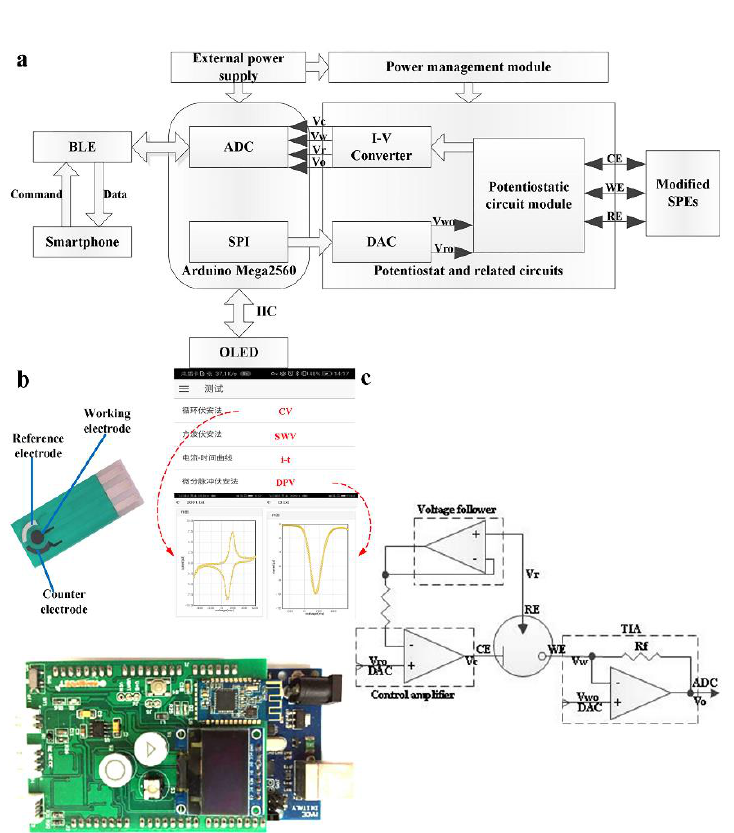
Figure 1. ( a ) The schematic diagram of the smartphone-based electrochemical biosensing system; ( b ) The images of components of the system; ( c ) The schematic diagram of potentiostat and I–V